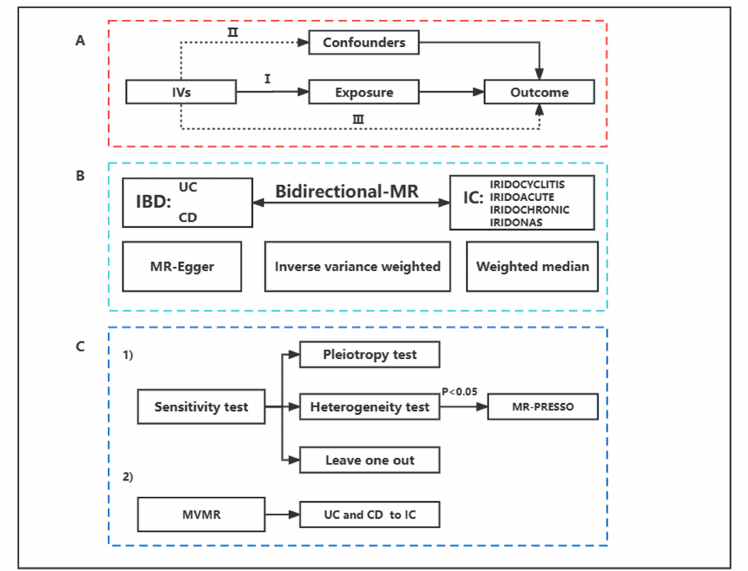
Figure 1. An overview of the study design. ( A ) Illustration of MR. MR is based on three princi- pal assumptions: (I) the IVs are associated with the exposure; (II). the IVs are not associated with confounders; (III). the IVs influence the outcome only through no other ways but exposure. ( B ) Illus- tration of bidirectional MR. When IBD was set as exposure, IC was the outcome. When IC was set as exposure, IBD was the outcome. Three MR methods were performed to assess the causal estimations between IBD and IC, including inverse-variance weighted, MR Egger, and weighted median, whereas the first was used as the main analysis. IBD data included UC and CD. IC data included IRIDOCYCLI- TIS (IC as a whole), IRIDOACUTE (acute and subacute IC), IRIDOCHRONIC (chronic IC), IRIDONAS (other and unspecified IC). ( C ) Illustration of sensitivity analysis and MVMR. (1): MR-Egger intercept test was used to assess pleiotropy. Cochran’s Q test was used to detect heterogeneity. MR-PRESSO